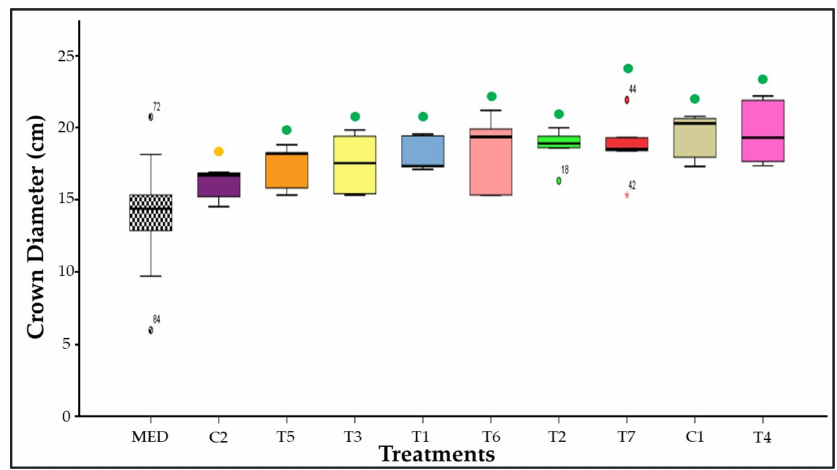
Figure 3. Crown diameter extension in strawberries inoculated with Azospirillum brasilense , Bacillus megaterium , and Brevibacillus fluminis , alone and in mixtures. MED : Cluster with measurements of all treatments on day 0. Clusters of controls and treatments represent their respective mean crown Agronomy 2022 , 12 , x FOR PEER REVIEW 0.037 ± 0.007a ⬤ 〇 Closed ( ⬤ ) and open ( 〇 ) circles indicate comparisons withs Controls 1 and 2, respectively. Green, diameter at day 15. Closed circles ( ) indicate the comparison of means in relation to MED cluster. yellow, and red circles indicate that the values are higher than, equivalent to, or lower than those The coloring of the circles suggests that according to Dunnet’s test ( p ≤ 0.05), the values are higher observed in the controls, according to the Kruskal–Wallis test ( p ≤ 0.05) and pairwise comparison than those observed in the MED cluster when green, equivalent to them when yellow, and lower with the Dunn test ( p ≤ 0.05). Means followed by the same letter do not differ statistically. Control than them when red. C1: control without inoculation + fertilization 100% of N and P; C2: control 1: control without inoculation + fertilization 100% of N and P; Control 2: control without inoculation without inoculation + fertilization 30% of N and P; T1 : Azospirillum brasilense Ab-v5; T2: Bacillus + fertilization 30% of N and P; Treatment 1: Azospirillum brasilense (Ab-v5), Treatment 2: Bacillus megaterium 0004; T3: Brevibacillus fluminis MET12M2; T4: Ab-v5 + 0004; T5: Ab-v5 + MET12M2; T6: megaterium (0004); Treatment 3: Brevibacillus fluminis (MET12M2); Treatment 4: Ab-v5 + 0004; Treatment 5: Ab-v5 + MET12M2; Treatment 6: 0004 + MET12M2; Treatment 7: Ab-v5 + 0004 + MET12M2.